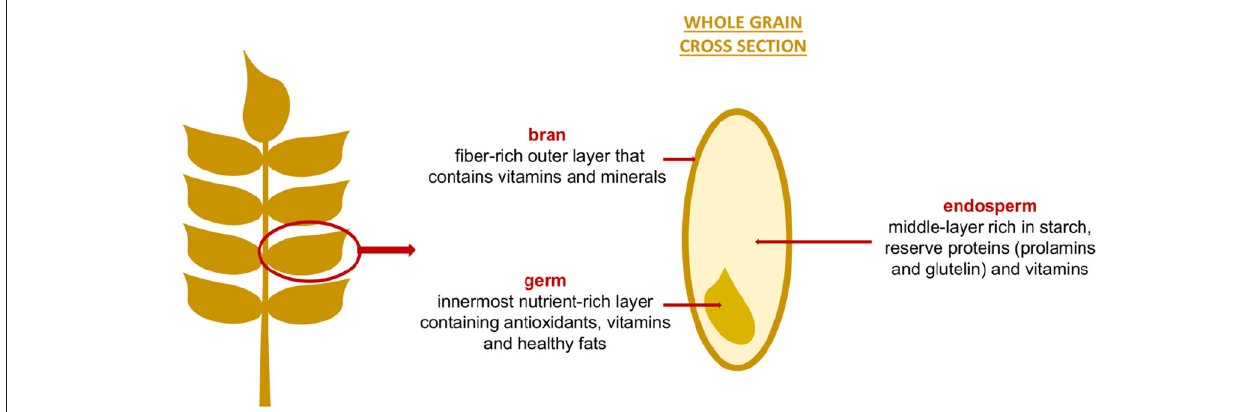
FIGURE 1 | Structure and composition of grains.